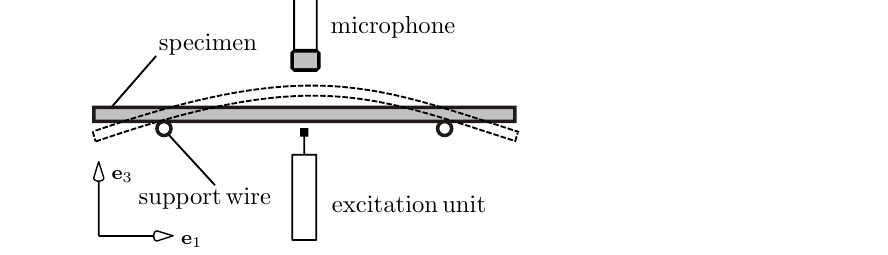
Figure 4. Sketch of the experimental setup for determination of E 1 , with respect to the specimen basis ( e 1 , e 3 ) from the fundamental flexural eigenfrequency f f